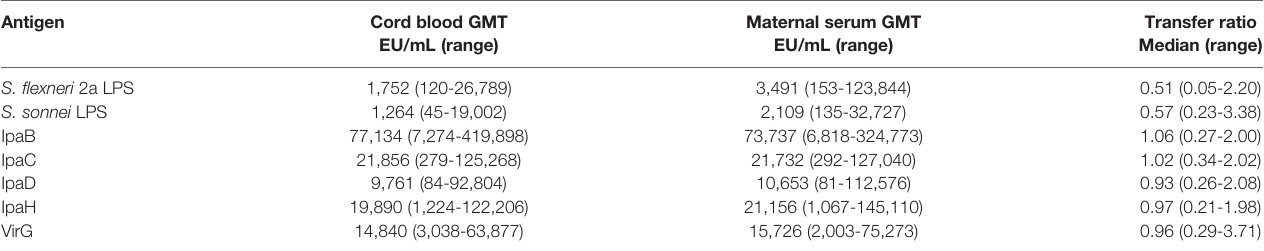
TABLE 2 | Shigella antigen-speci fi c titers. Antigen Cord blood GMT Maternal serum GMT Transfer ratio EU/mL (range) EU/mL (range) Median (range)